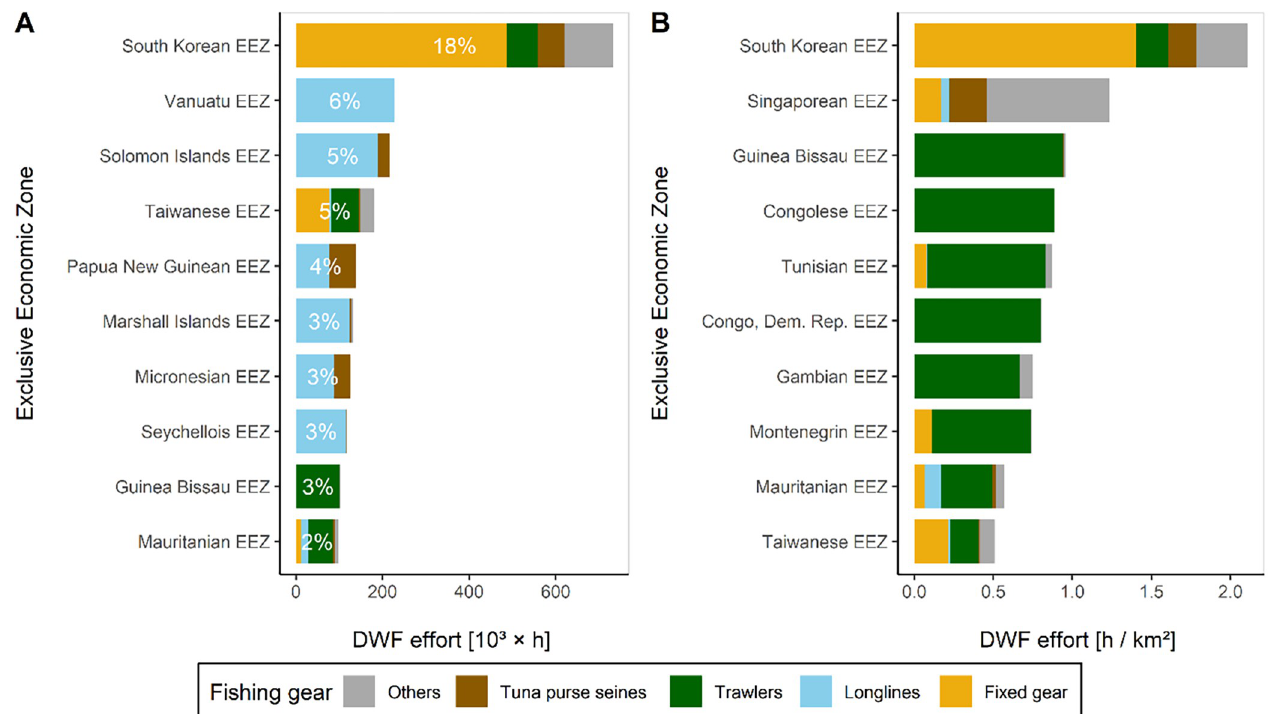
Fig 4. Aggregated distant water fishing effort (2017) by host countries’ exclusive economic zone (EEZ) as (A) total hours and (B) total hours divided by EEZ area. Numbers in the bars in chart A indicate the global percentage of the total distant water fishing effort received by each EEZ in 2017. Displayed are the 10 highest ranking EEZs,